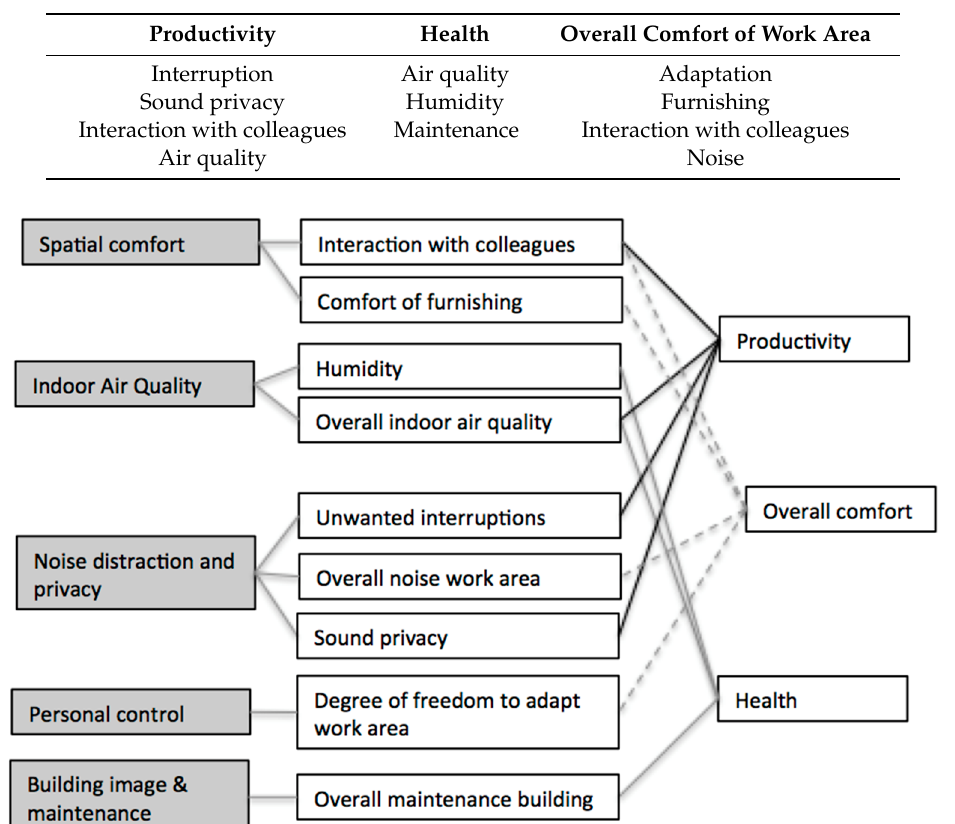
Figure 3. Best-performing features of private offices for predicting perceived productivity, health, and overall comfort work area.